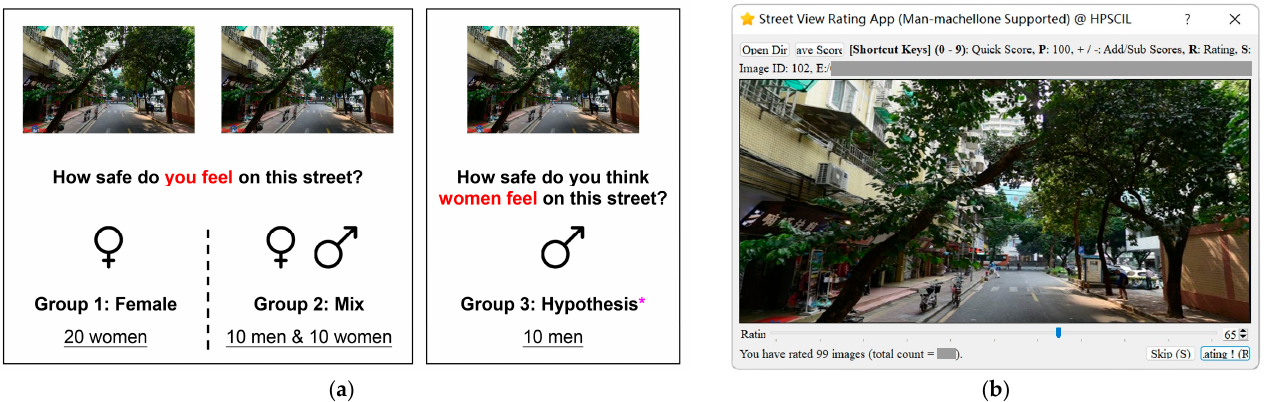
Figure 4. Volunteers’ ( a ) grouping and ( b ) scoring interface created by Yao et al. [65] (* indicates 10 men asked to perceive as women).